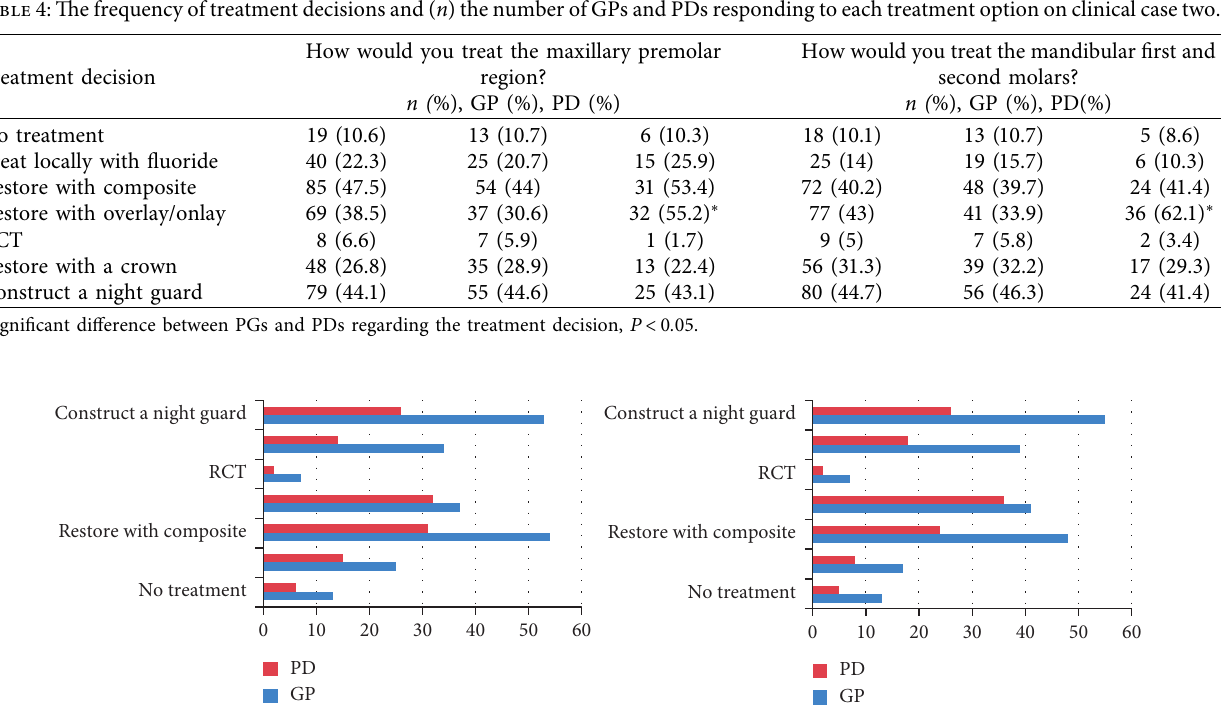
Figure 7: Frequencies of treatment decisions among GPs (general practitioners) and PDs (prosthodontists) regarding case two.